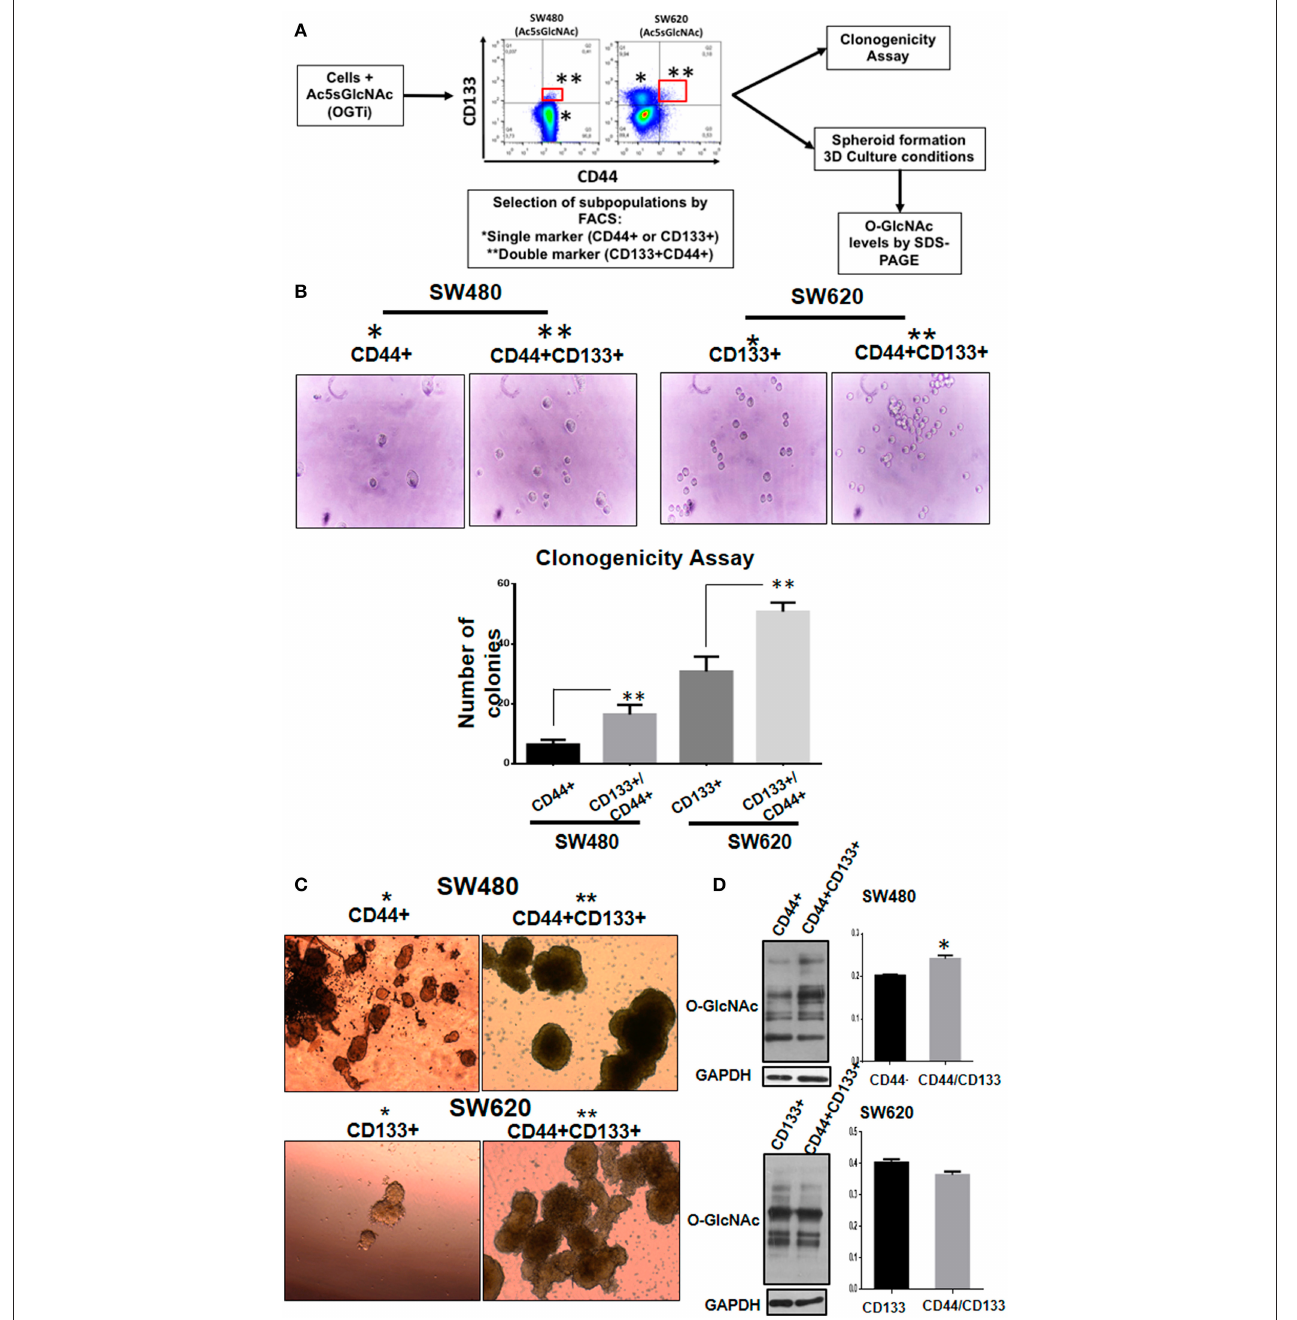
FIGURE 5 | Double positive CD133/CD44 stem subpopulations induced as result of OGT inhibition display more aggressive phenotype compared with single positive subpopulations. (A) Schematization of the experimental approach used. (B) Clonogenicity assay. Isolation by FACS of the single and double positive populations was performed. Cells co-expressing CD44 and CD133 (marked in red) were isolated and grown under different culture conditions. Cells were cultured in DMEM F12 with ITS to evaluate colony formation. Bar graphs shown represent the mean ± SEM of three independent experiments. * p = 0.01; ** p = 0.001 ( t -test) compared with control. (C) Spheroid culture. Cells were cultured in ultra- low adherence 24-well plates with medium supplemented with EGF and B27. After 3 weeks of incubation pictures of the spheres were taken. For comparison, cells expressing only one marker (CD44 for SW480 and CD133 for SW620) were cultured under the same conditions. The spheres were lysed and levels of O-GlcNAc expression were evaluated. Isolation of cells by FACS -cell sorting was performed in MOFlow cytometer. (D) The spheres were lysed and levels of O-GlcNAc expression were evaluated by Western blotting. GAPDH were used as a load control. The results shown are representative of at least three independent experiments using different cell preparations. A densitometric analysis of the expression levels found is shown at the right and the data represent the means ± SEM from at least three independent experiments. * p = 0.01 ( t -test) compared with single positive CD44 + spheroids.